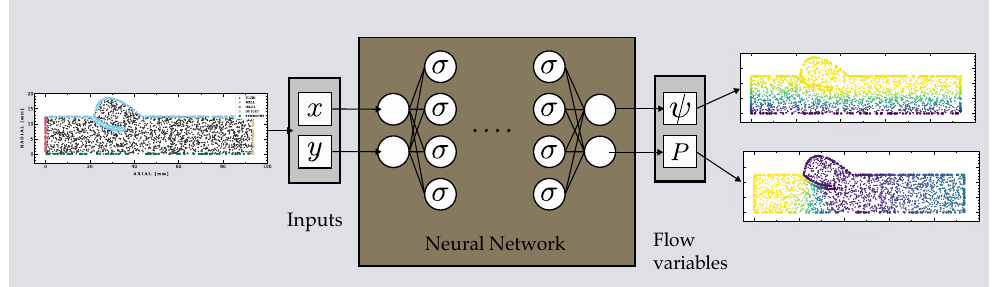
Figure 2. Neural network as a general function approximator for approximating the solution of a partial differential equation (PDE). Several input coordinates are passed to the network, and the output is the predicted flow field. Here, the flow field is expressed as the scalar stream function ψ and scalar pressure field p